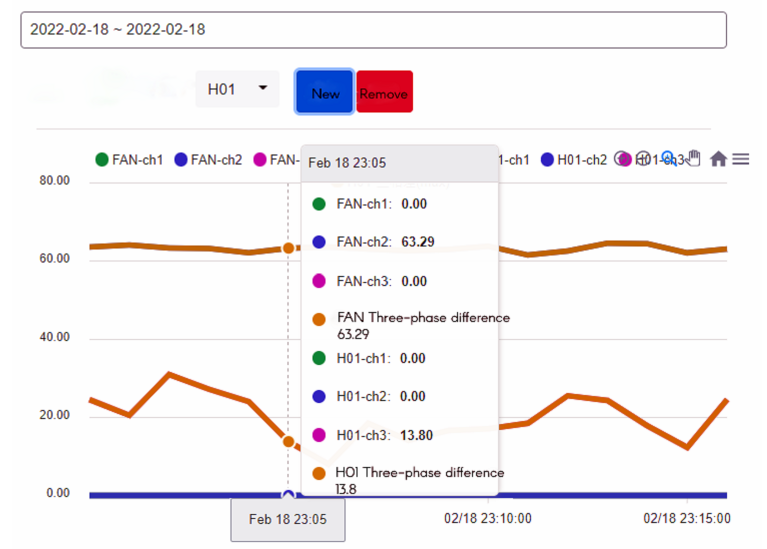
Figure 8. Comparison of devices, press furnace heat, equipment, and abnormal time values.